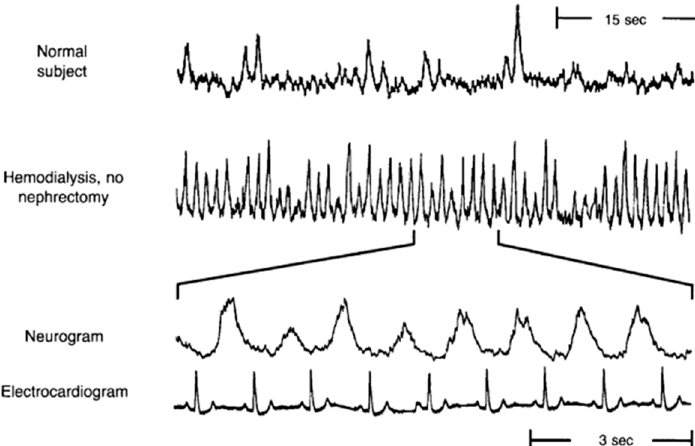
Figure 1. Original record of muscle sympathetic nerve activity (MSNA) in a normal subject and a renal failure patient on hemodialysis, demonstrating significantly greater resting MSNA in the dialysis patient. The bottom two panels display a portion of the neurogram and simultaneous electrocardiogram from the patient on hemodialysis showing that the renal failure patient has a burst of MSNA with every cardiac cycle. (Modified from Converse et al. [11] with permission).